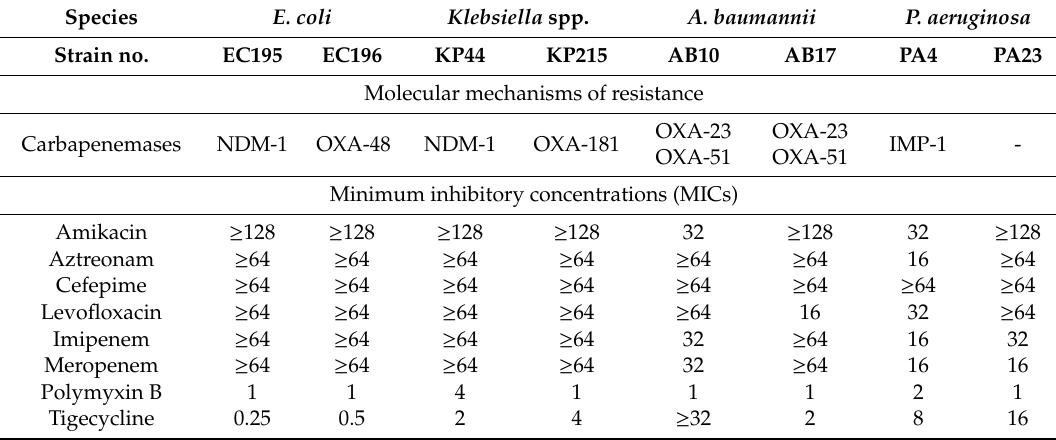
Table 1. Minimum inhibitory concentrations (mg / L) and resistance mechanisms of the eight carbapenem resistant Gram-negative bacteria (CR-GNB) clinical isolates. Species E. coli Klebsiella spp. Strain